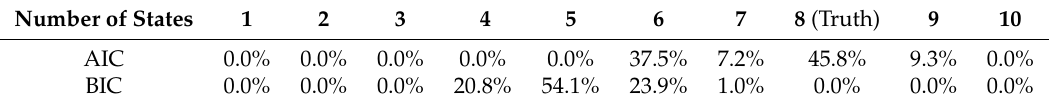
Table B1. Using AIC and BIC to choose the number of states in a hidden Markov model fit. Here, we take an actual model from our data (the 8-state best fit model for the God page), use that model to generate a new time series of equal length (10,731 samples) and attempt to fit a new model, using either AIC or BIC to select the preferred number of states in a manner similar to Refs. [92,93]. The table lists the fraction of the time this process led to a preferred machine of each size, for the two different penalties. Both AIC and BIC tend to underestimate model complexity; in general, BIC performs worse, significantly underestimating the true number of states. AIC performs better, recovering the correct number of states nearly half the